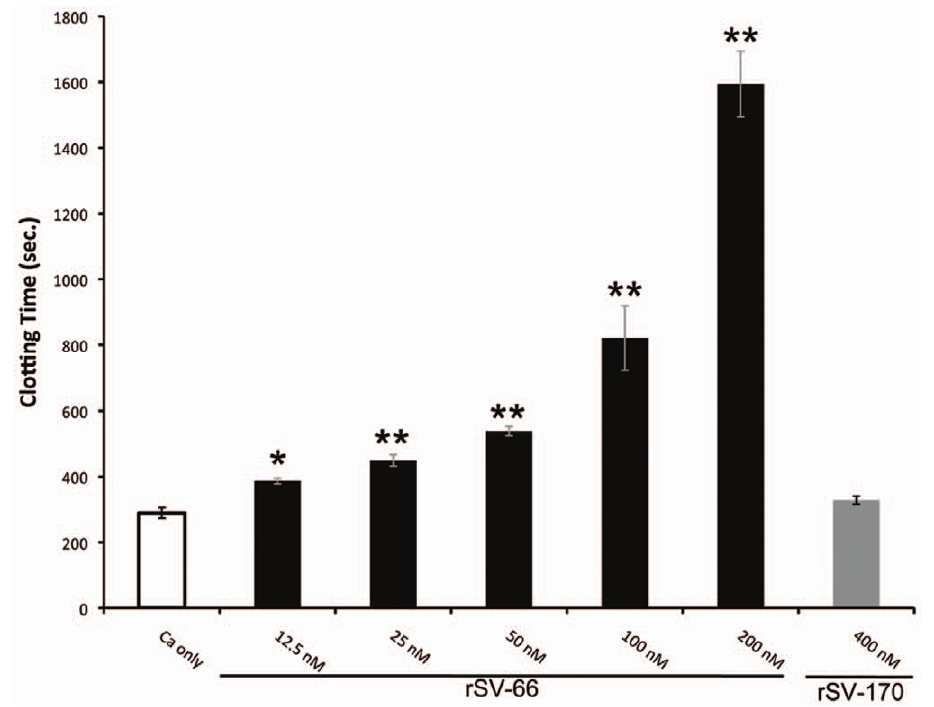
Figure 3. rSV-66 delays clotting of human plasma. Indicated concentrations of rSimukunin (rSV-66) and rSV-170 were tested by the recalcification time assay. Citrated human plasma (50 m l) was mixed with recombinant proteins (in 50 m l 0.15 M NaCl, 10 mM HEPES pH7.4) and pre- warmed at 37 u C for 15 min before clotting was initiated by the addition of 50 m l prewarmed CaCl 2 (25 mM). Recalcification (clotting) time was determined by monitoring absorbance at 650 nm at 10-sec intervals in a SpectraMax 340 microtiter plate reader, with onset time (the time to a linear increase in the OD, which reflects the maximal rate of formation of insoluble fibrin) set at an OD of 0.04. Clotting times (mean 6 SD) for rSimukunin and rSV-170 are shown in black bars and grey bars, respectively. The white bar is the Ca 2 + -only control. One-way analysis of variance indicted a significant difference between treatments (F 6, 21 =119.3; P , 0.001) for rSimukunin but not rSV-170. Subsequent multiple comparisons between various treatments and the positive control were performed using the Holm-Sidak method. Statistically significant increases in clotting time at p , 0.05 and p , 0.01 are indicated by * and ** respectively. Results shown are representative of three independent experiments.